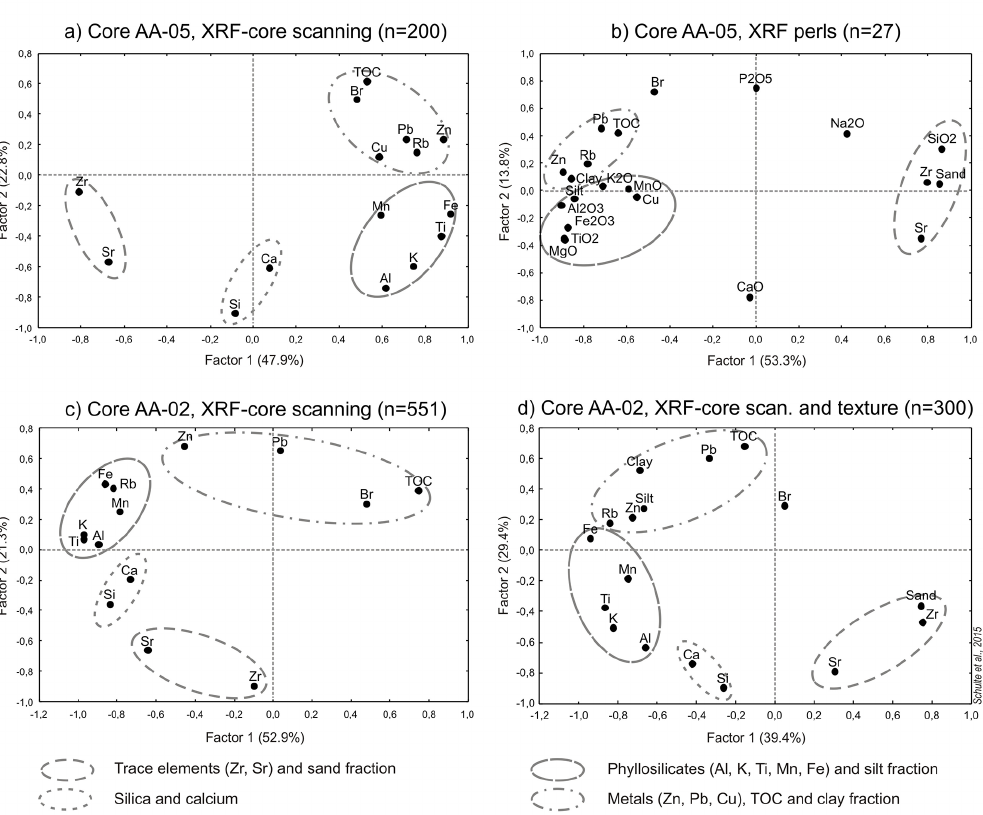
Figure 4. 2-D plots of factor loadings (factor analysis) of chemical major and minor elements, TOC and grain-size fractions of core AA-02 and AA-05